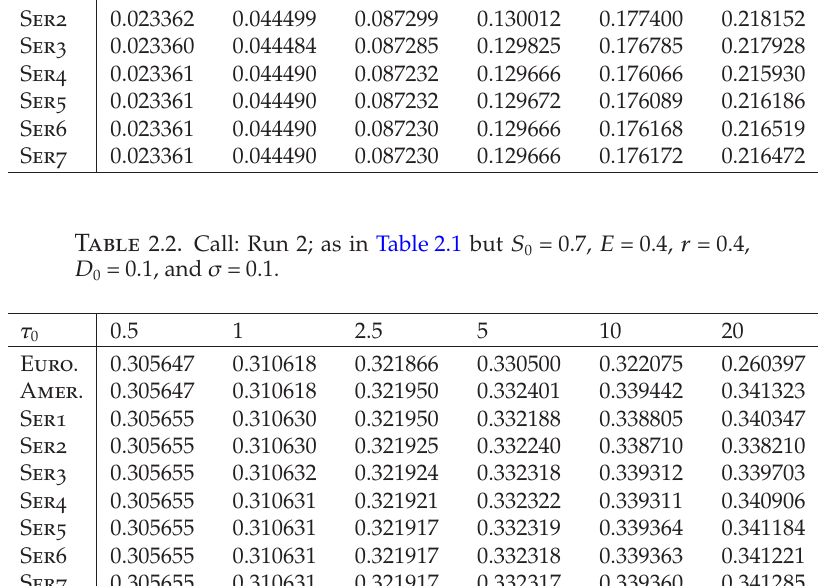
= 0 . 8, E = 0 . 9, r = 0 . 05 , D = 0 . 04, σ = 0 . 25. Table 2.1 . Call: Run 1; S 0 0 Euro. and Amer. are values of European and American options com- puted using a 100,000 step binomial tree. Remaining columns are the values of an American option computed using a 100,000 path Monte Carlo simulation taking series ( 1.3 ) as the exercise boundary ( Ser1 uses one term in the series, Ser2 uses two terms, etc. ) .